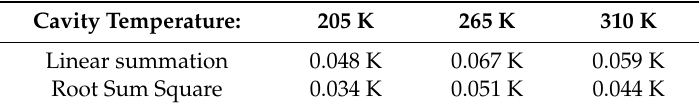
Table 4. Uncertainty of the LABB temperature for 3 cavity